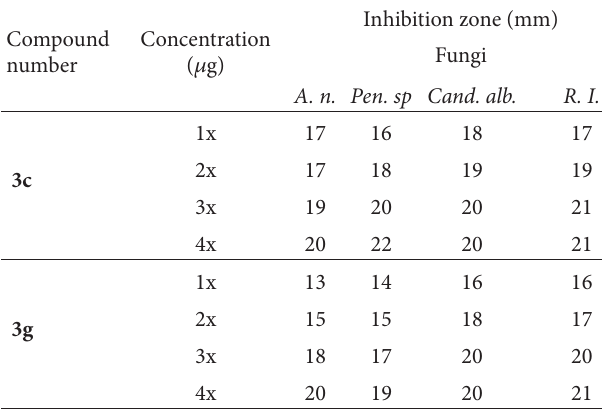
T 3: Effect of different concentrations of compounds 3c and 3g showed moderate activity on fungal